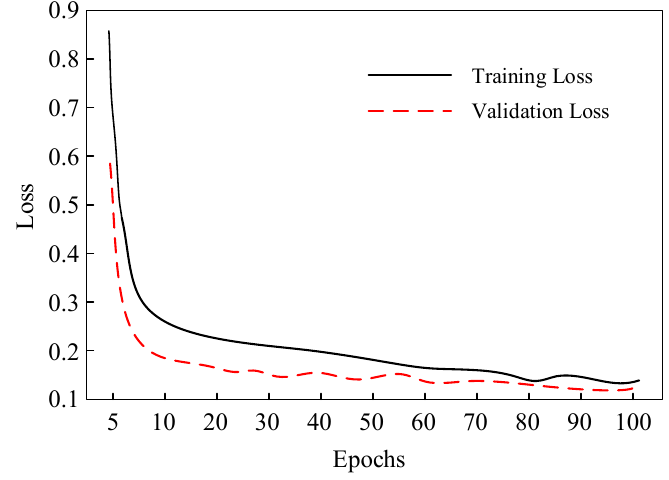
Figure 6. Loss of training set and validation set.